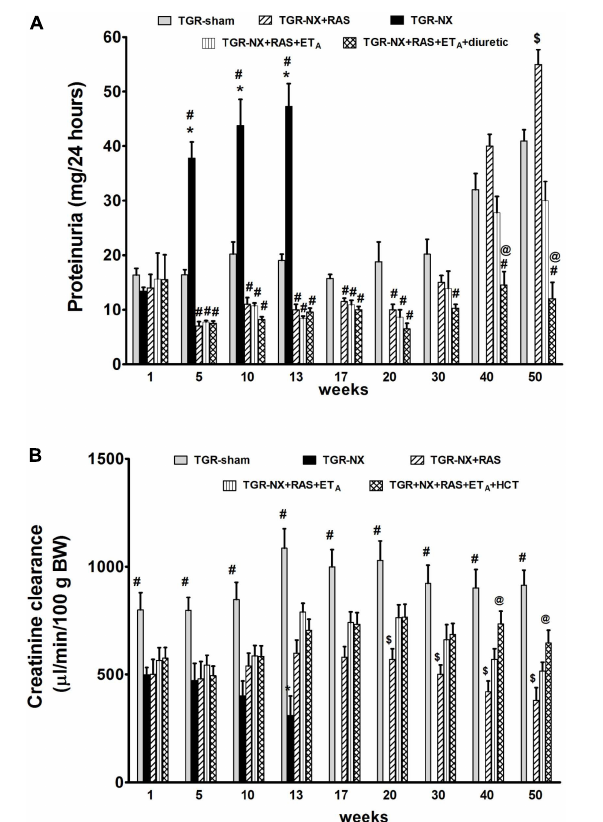
FIGURE 3 | The effect of diuretic treatment added to combined RAS and ETA blockade on proteinuria and creatinine clearance. Proteinuria (A) and creatinine clearance (B) in sham-operated TGR (TGR-sham), nephrectomized TGR (TGR-NX) untreated receiving water or treated with the renin-angiotensin system (RAS) blockade alone (TGR-NX + RAS), combined RAS + ET A blockade (TGR-NX + RAS + ET A ), or diuretic given with the combined RAS + ET A blockade (TGR-NX + RAS + ET A blockade + diuretic). # P < 0.05 TGR-sham vs. other TGR-NX-treated groups, $ P < 0.05 TGR-NX + RAS treated vs. other TGR-NX-treated groups, @ P < 0.05 TGR-NX + RAS + ET A + diuretic vs. other TGR-NX-treated groups, ∗ P < 0.05 untreated TGR-NX group compared with all other treated TGR-NX groups at the same time